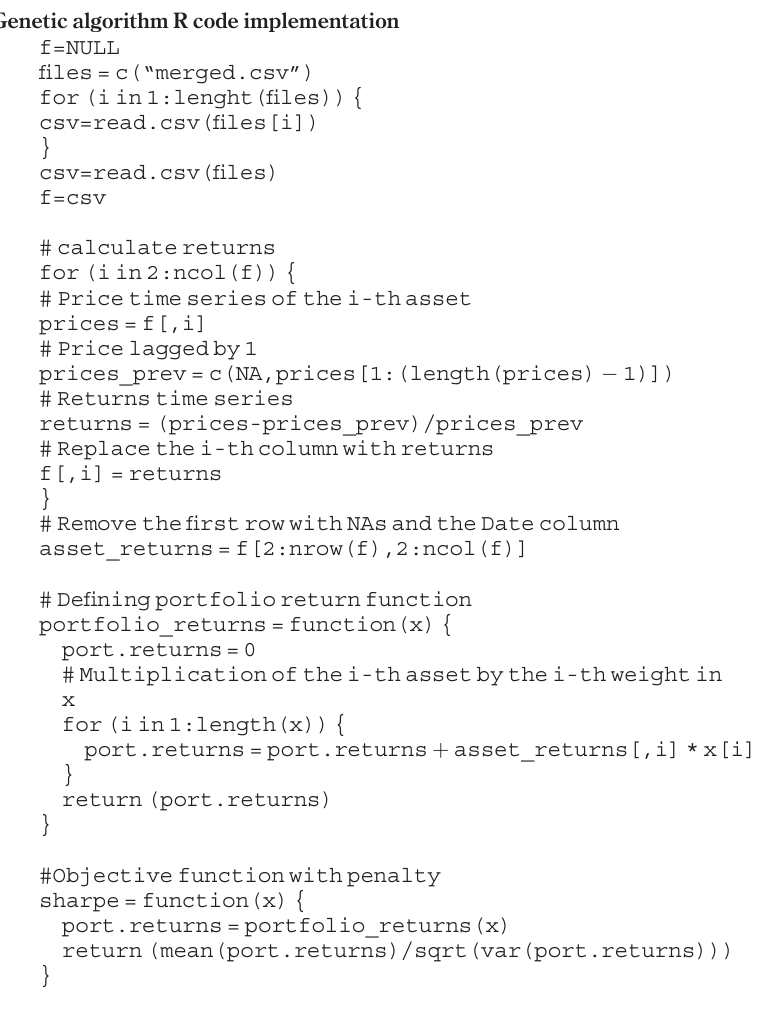
Genetic algorithm R code